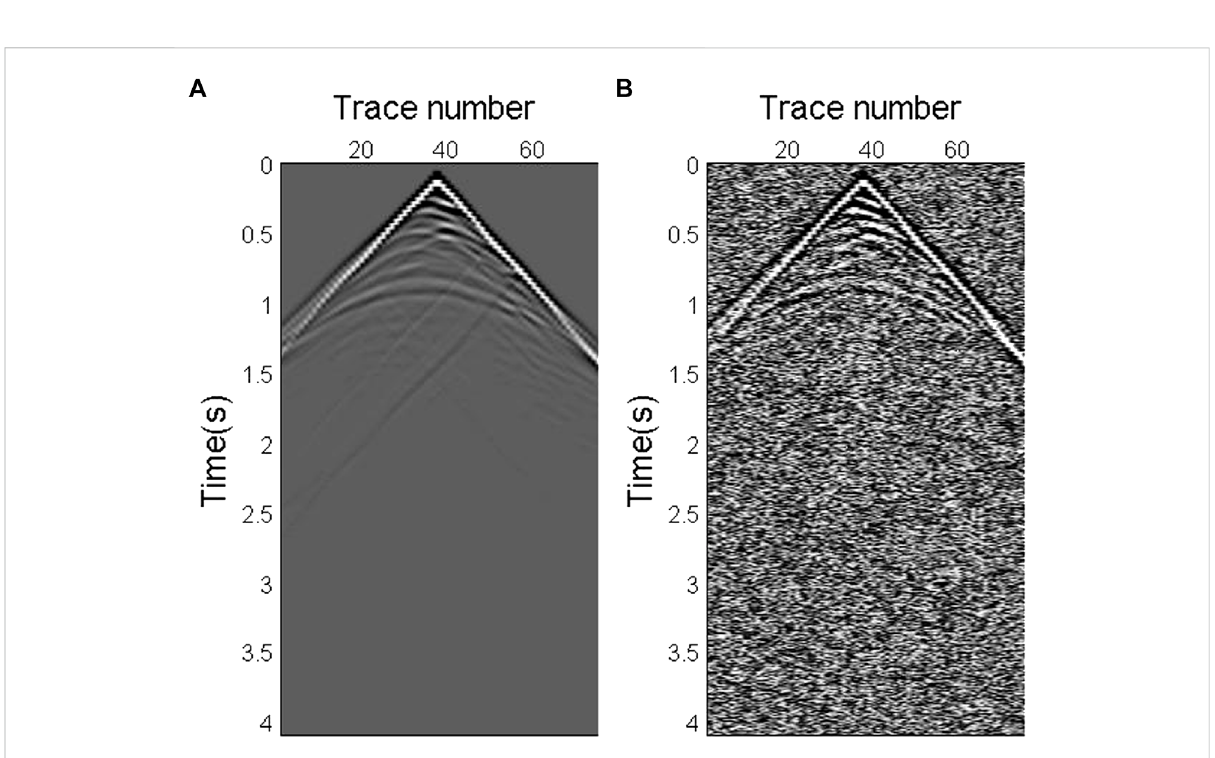
inversion result using mL-BFGS method is less different from the true model and more accurate. The convergence curves of the L-BFGS and mL-BFGS methods are shown in Figures 7A,B, respectively. The vertical axis denotes the value of the mis fi t function, and